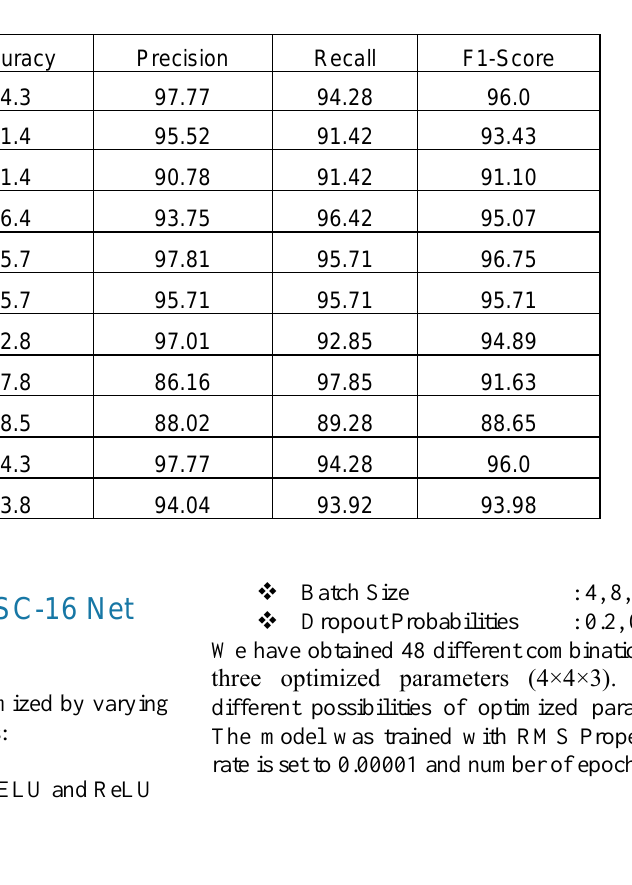
Table 4. Performance Metrics of VGG-16 Net